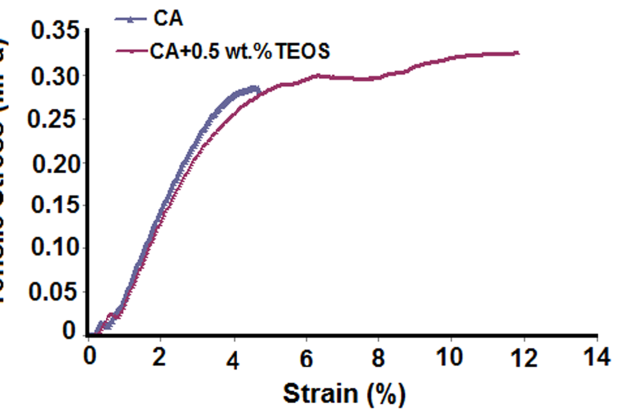
Table 5. Surface tension parameters (